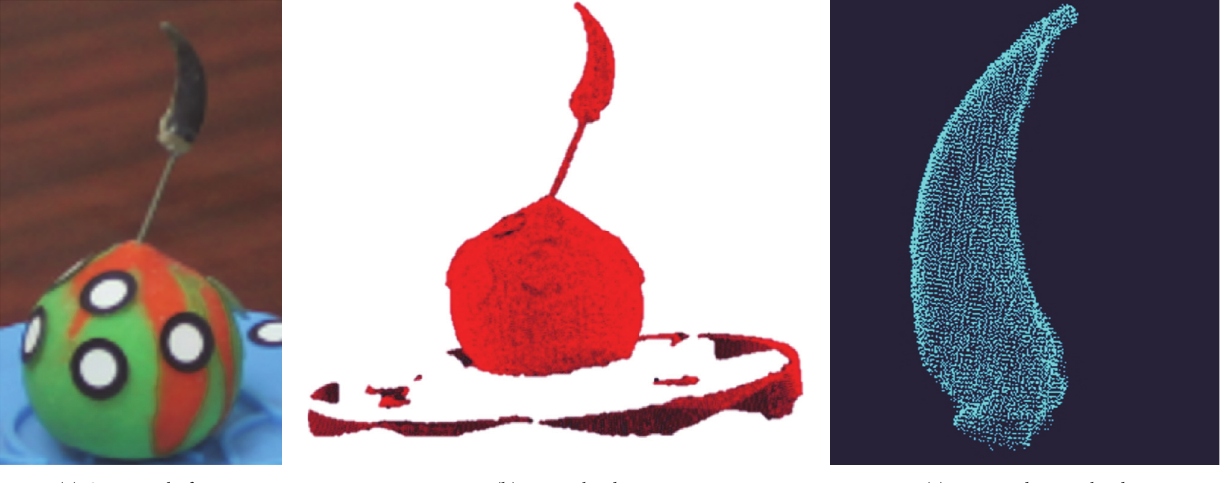
Figure 4: Point cloud for Himalayan marmot claw.